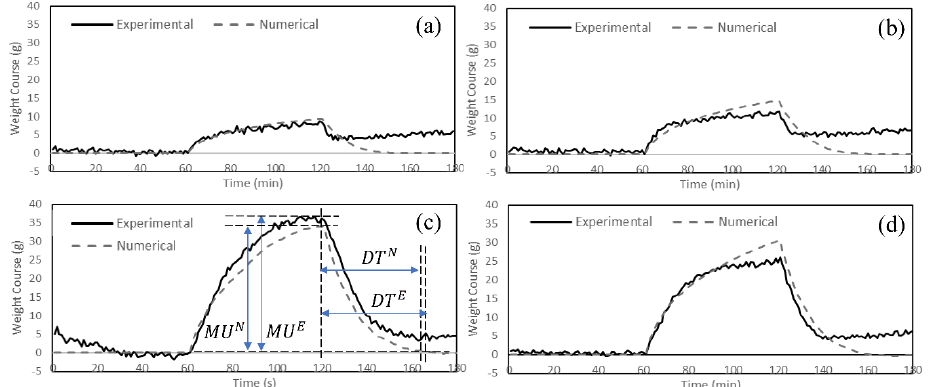
Figure 5. Weight course during 3 phases of measurements for ( a ) Fabric A, ( b ) Fabric B, ( c ) Fabric C, and ( d ) Fabric